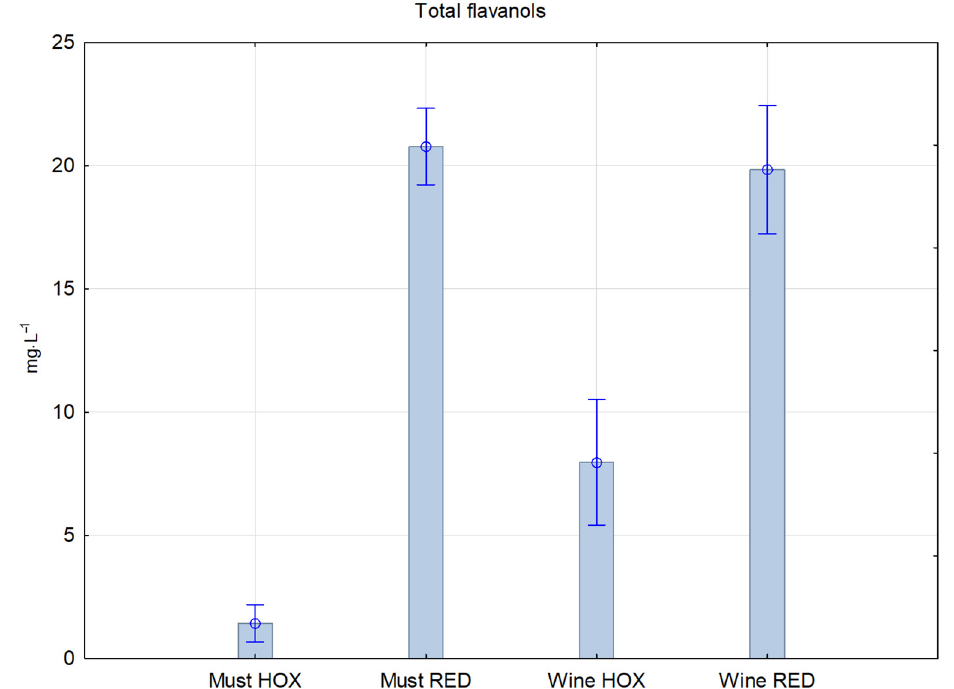
Figure 3. Concentration of total flavanols in reductive and hyperoxidized musts and wines. A comparison of total polyphenol concentration in Figure 4 shows a 30% decrease between the reductive and hyperoxygenated final wine samples. Motta , et al. [27] found that pressing the grapes in the presence of oxygen caused a significant decrease in the average concentration of total polyphenols ( − 23.7%) and catechins ( − 36.3%).